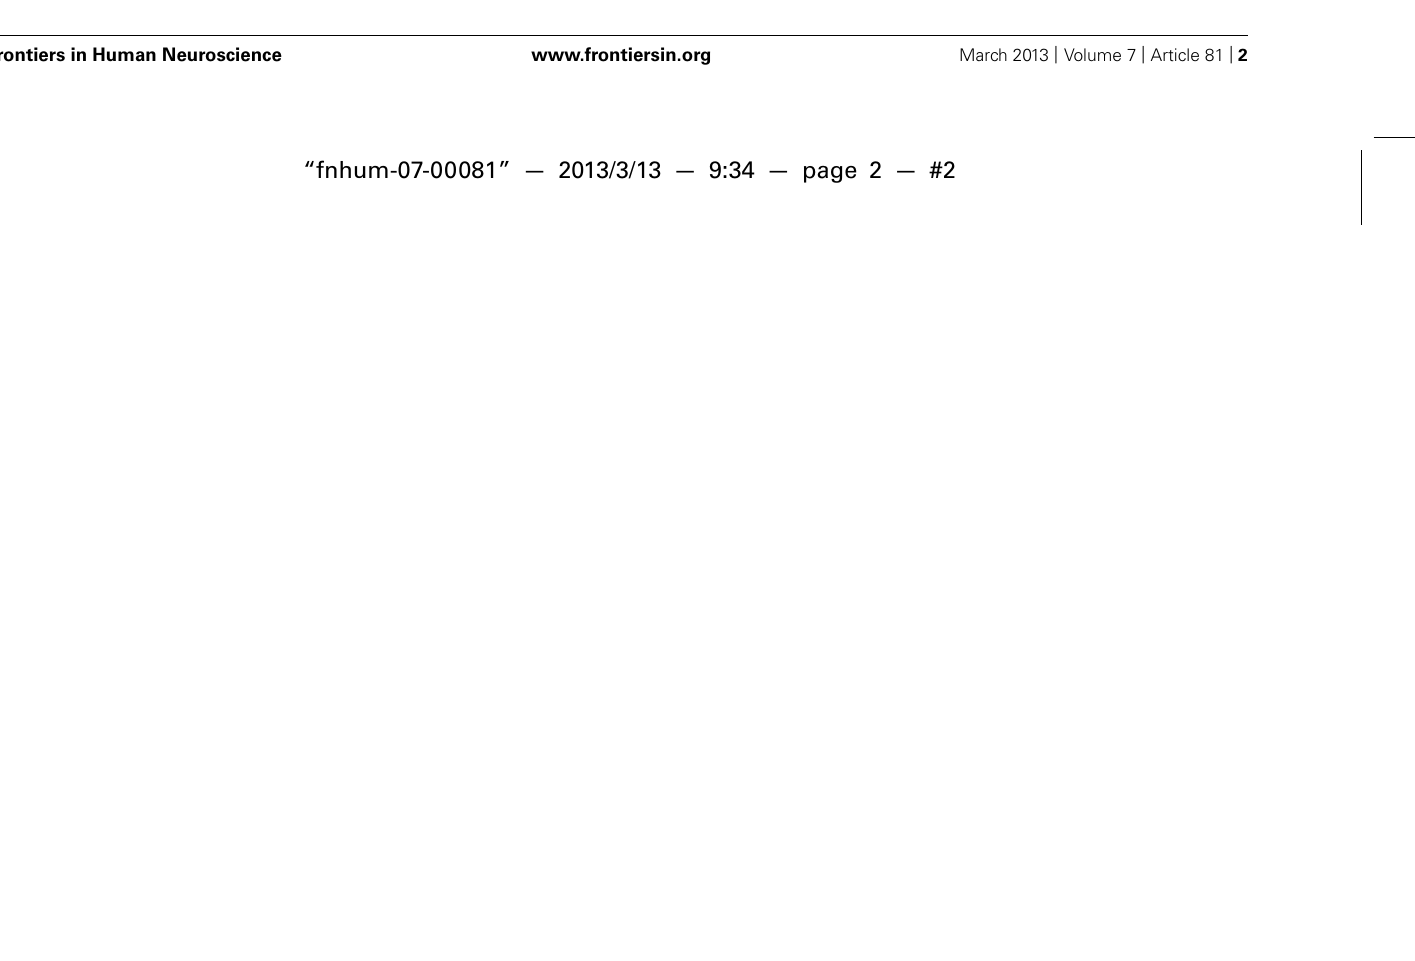
FIGURE 1 |Tentative models of sensorimotor adaptation. (A) Model of an adaptive mechanism that receives inputs I k from different sensory modalities distorted in different ways, and sends outputs O k to different effectors executing different types of movement. (B) More elaborate model that includes functional modules G i for gradual changes, X i for axis inversions,